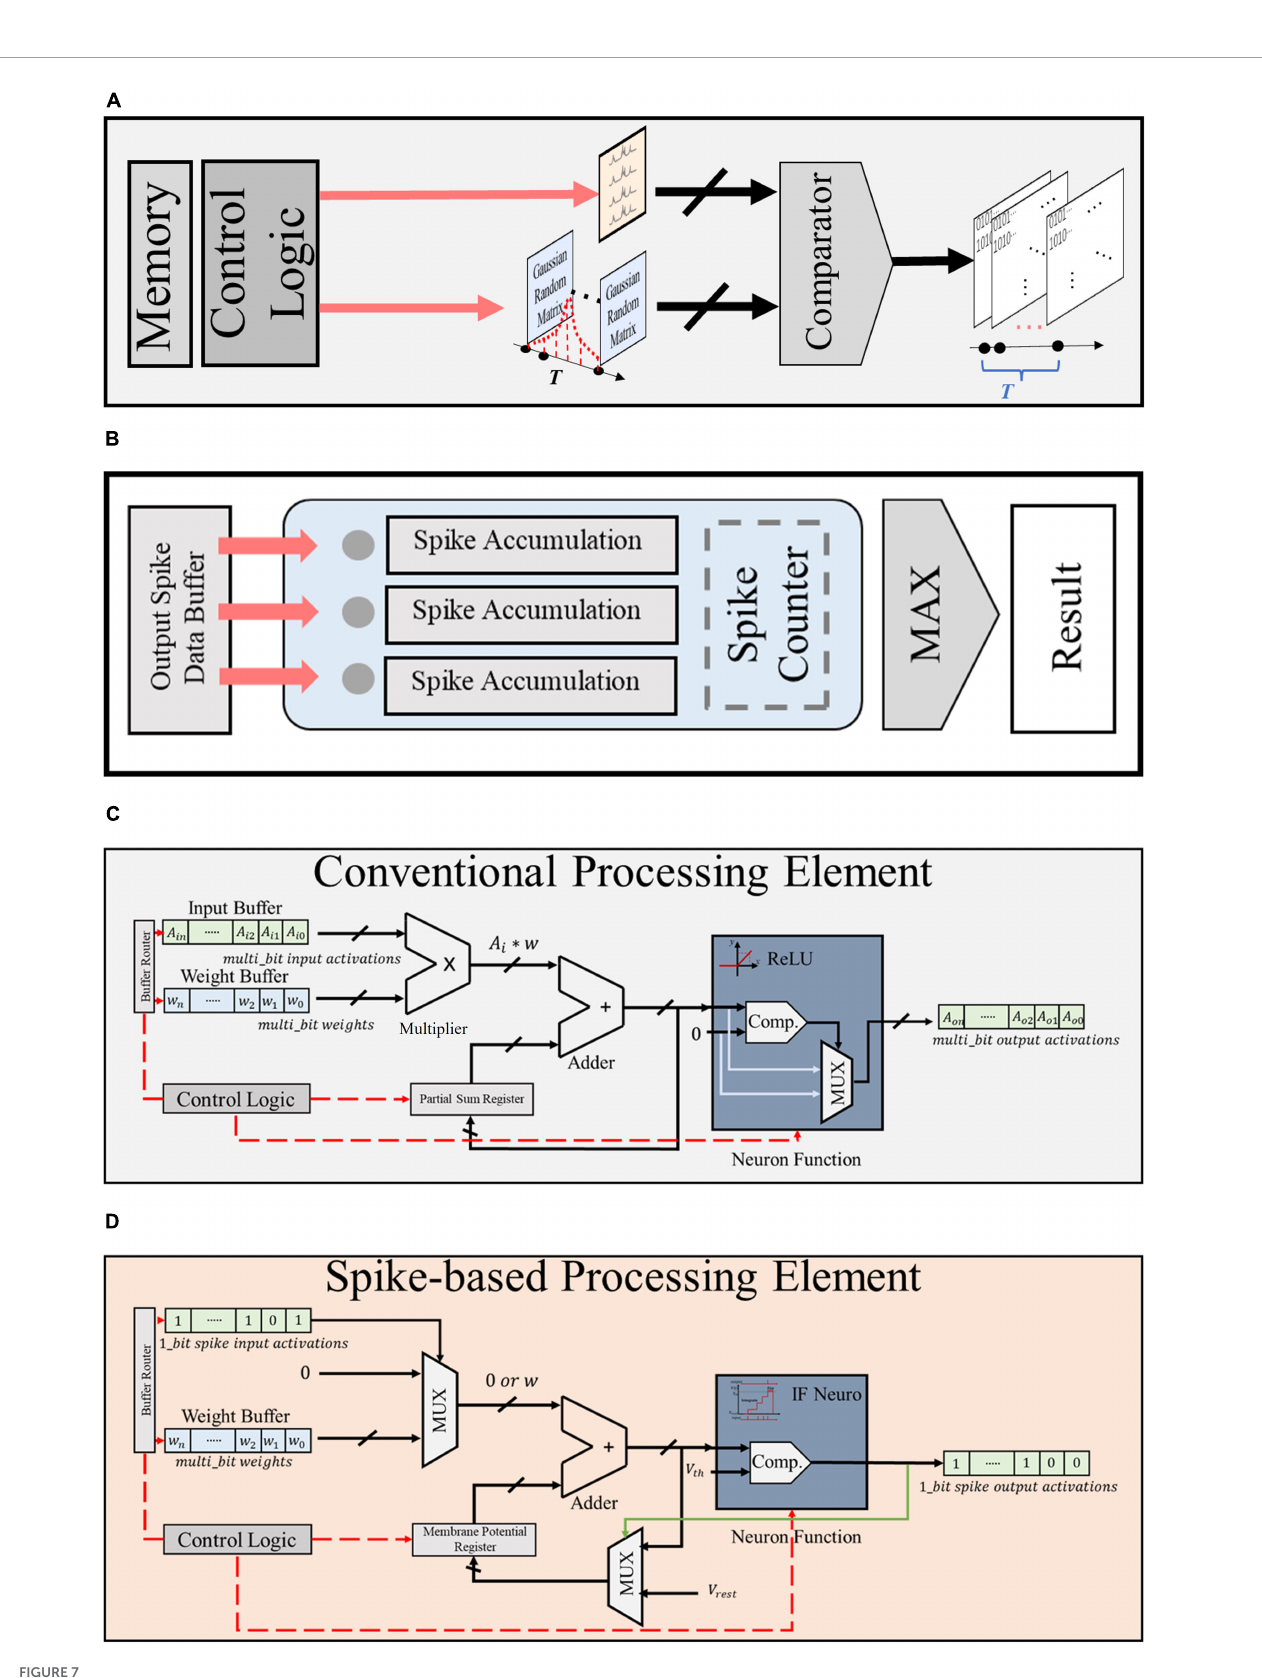
FIGURE7 Module design of (A) Gaussian spike encoder, (B) output spike counter, (C) conventional CNN-based PE, and (D) proposed spike-based